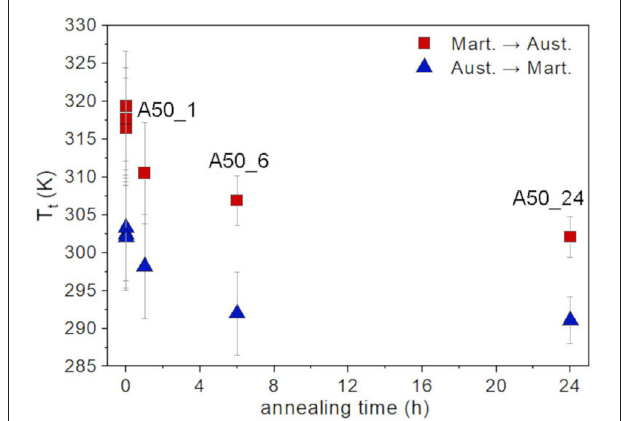
FIGURE 7 | Heating (red squares) and cooling (blue triangles) transition temperatures for fragments of the A50 sample subjected to heat treatments at 523K, reported as a function of the annealing time (0, 1, 6, and 24h). The error bar corresponds to the width at half maximum of the Gaussian function used to fit the distribution of the transition with temperature. The data are derived from M ( T ) measurements performed under an applied magnetic field of